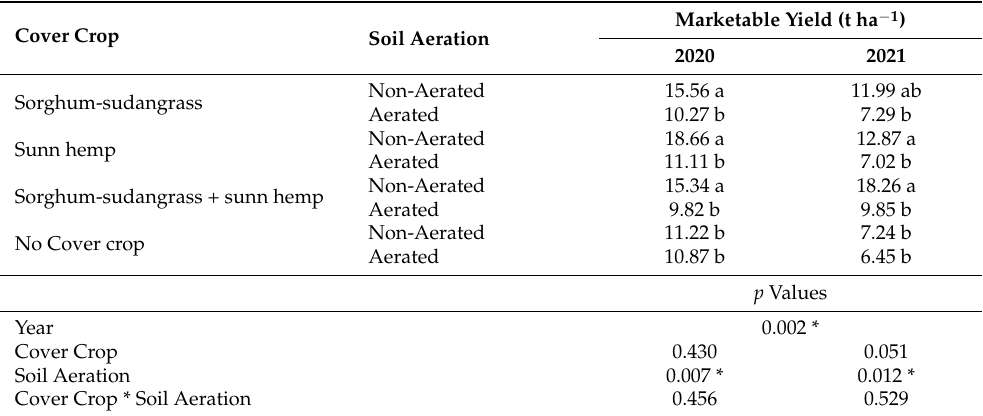
Table 4. Tomato yield in the 2020 and 2021 field experiments conducted at the organic research farm, Clemson University Coastal Research and Education Center (CREC), Charleston, SC, USA 1 . Marketable Yield (t ha − 1 ) Cover Crop Soil Aeration 2020 2021 Non-Aerated Sorghum-sudangrass Non-Aerated Sunn hemp Sorghum-sudangrass + sunn